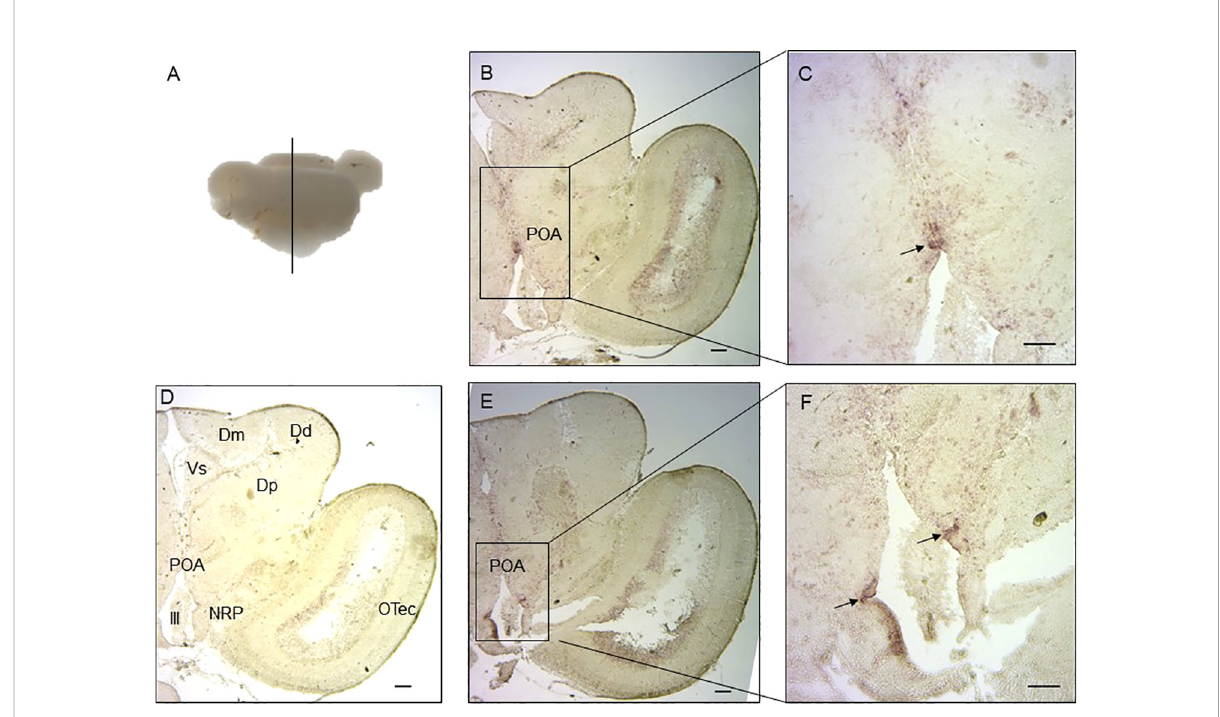
FIGURE 4 Localization of cells expressing VT and IT mRNAs in the lined seahorse brain. (A) Schematic diagram indicating the position of the coronal section and brain slides selected in the following. (B) In situ hybridization with an antisense VT mRNA probe showing the midbrain coronal section. (C) Enlarged part of the hypothalamus region using a VT antisense probe. (D) In situ hybridization with a sense VT probe within hypothalamus and midbrain regions of the lined seahorse. The brain regions are marked out in the micrograph. (E) . In situ hybridization with